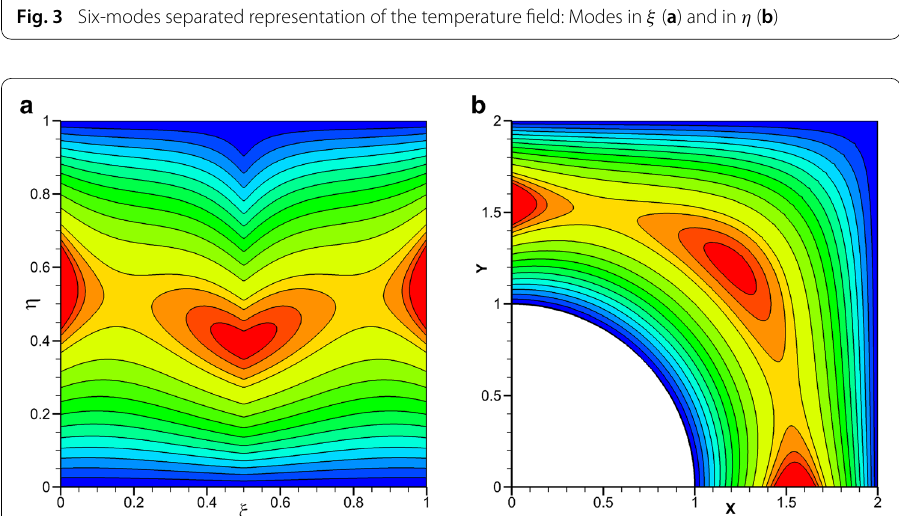
Fig. 4 Temperature field in the computational domain ( a ) and in the physical domain ( b